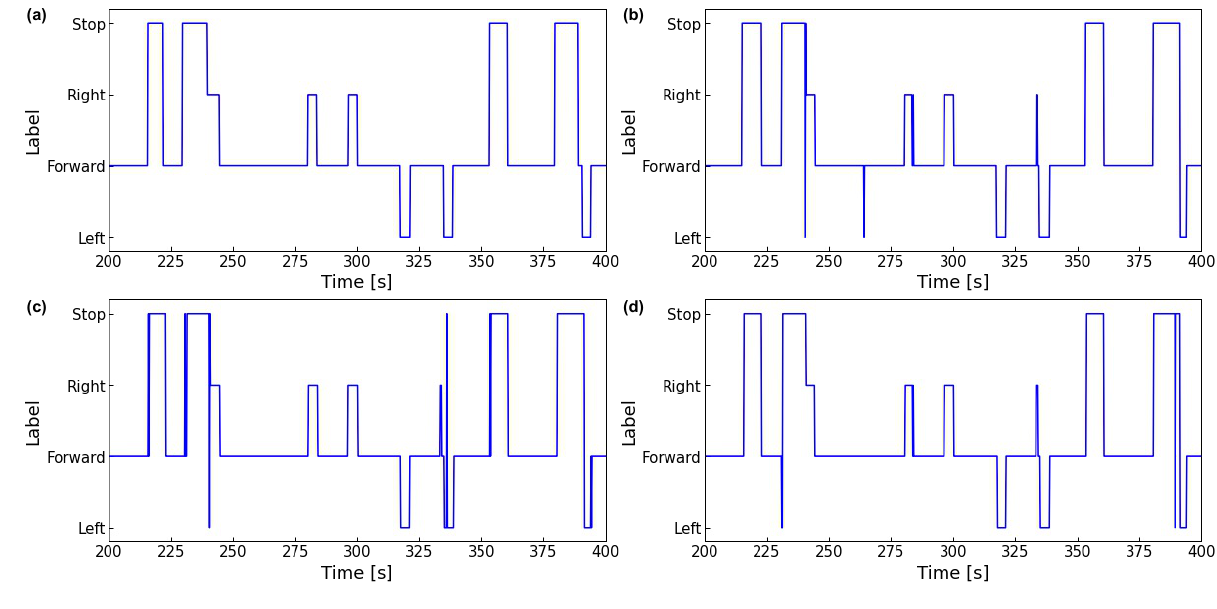
Figure 9. Comparison of output results of each model (200 s to 400 s): ( a ) Ground truth; ( b ) Output of 1DCNN-LSTM; ( c ) Output of 1DCNN; ( d ) Output of LSTM.